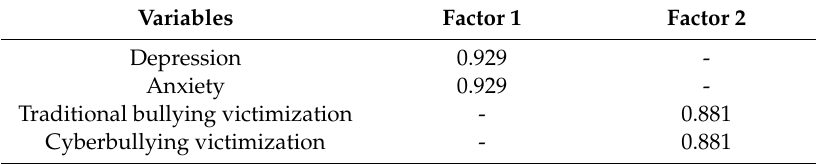
Table 2. Factor loading scores estimated by exploratory factor analysis for dimension reduction.